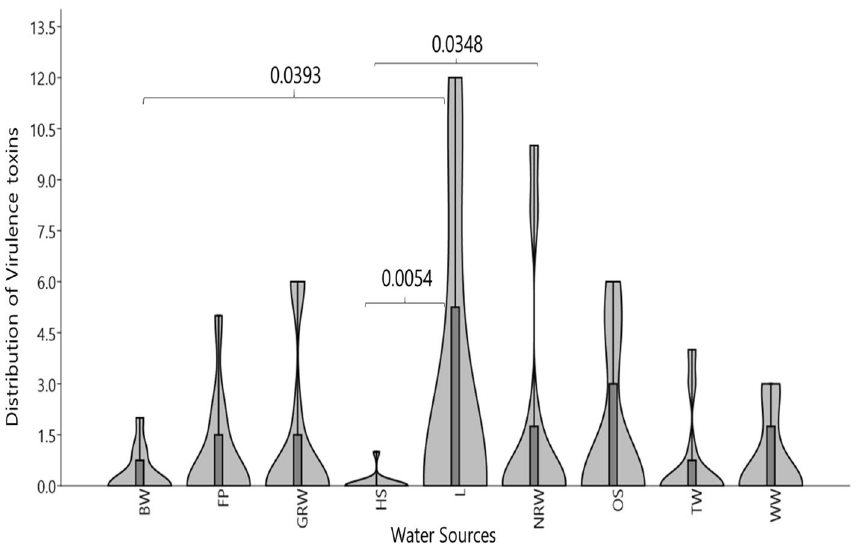
Figure 5. Distribution of Vibrio spp. Virulence determinants varied significantly on the surface waters in the districts by (Dunn’s post hoct, p ≤ 0.05). BW Bohole Water, FP fish pond, GRW ground running water, HS Hot